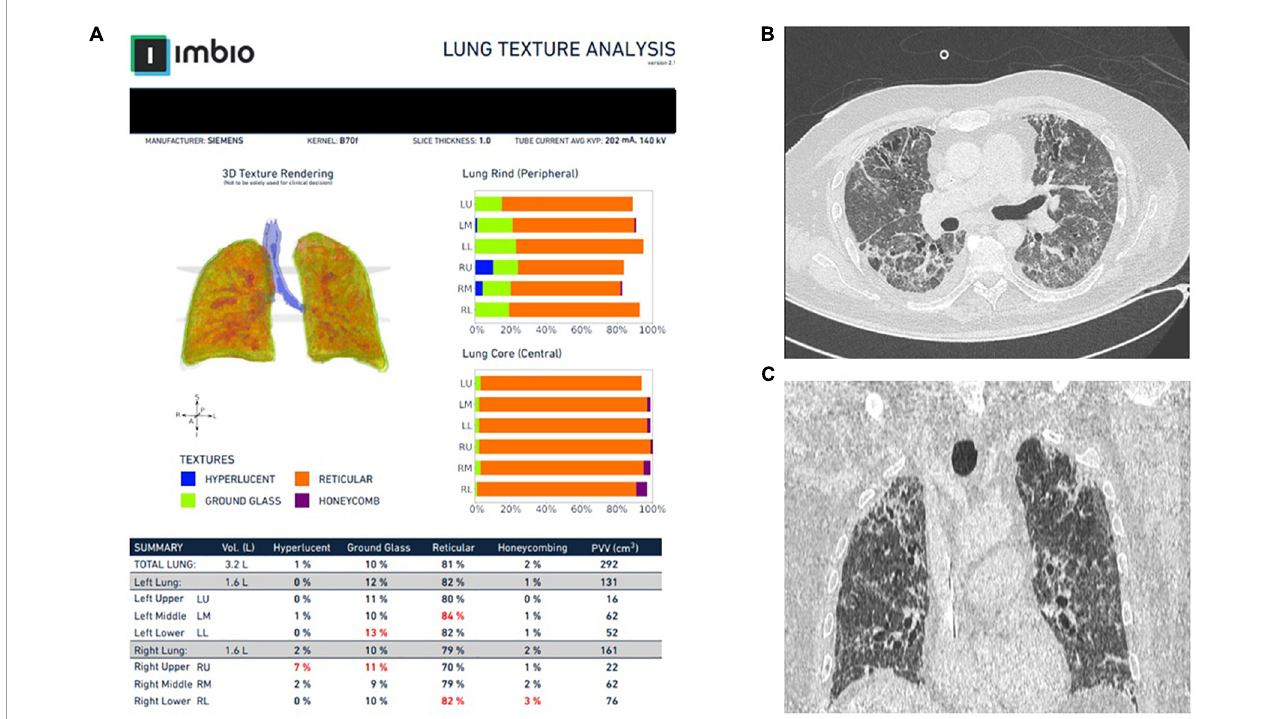
FIGURE3 Representative images from Imbio Lung Texture Analysis 2.1 of a patient with post-COVID-19-ILD (A) . Notice that almost 80% of the lung parenchyma presents with reticular abnormalities that are inconspicuous (at least to that extent) to the bear eye of the operator (B,C)